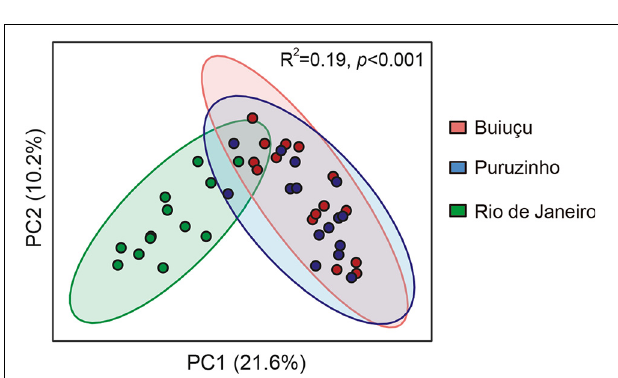
FIGURE 4 | Principal coordinate analysis of unweighted UniFrac distances showing beta diversity of the gut microbiome of individuals belonging to the three communities studied. Green circles represent subjects from Rio de Janeiro, red circles are subjects from Buiugu and blue represents subjects from Puruzinho. R2 and p value were calculated using ANOSIM.